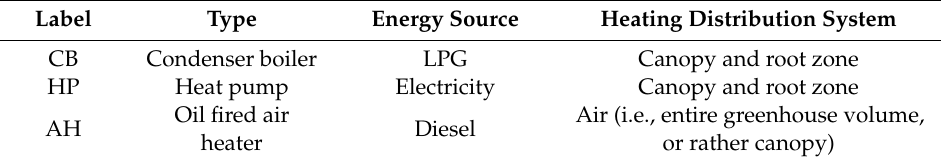
Table 1. The main characteristics of the three heating technologies.